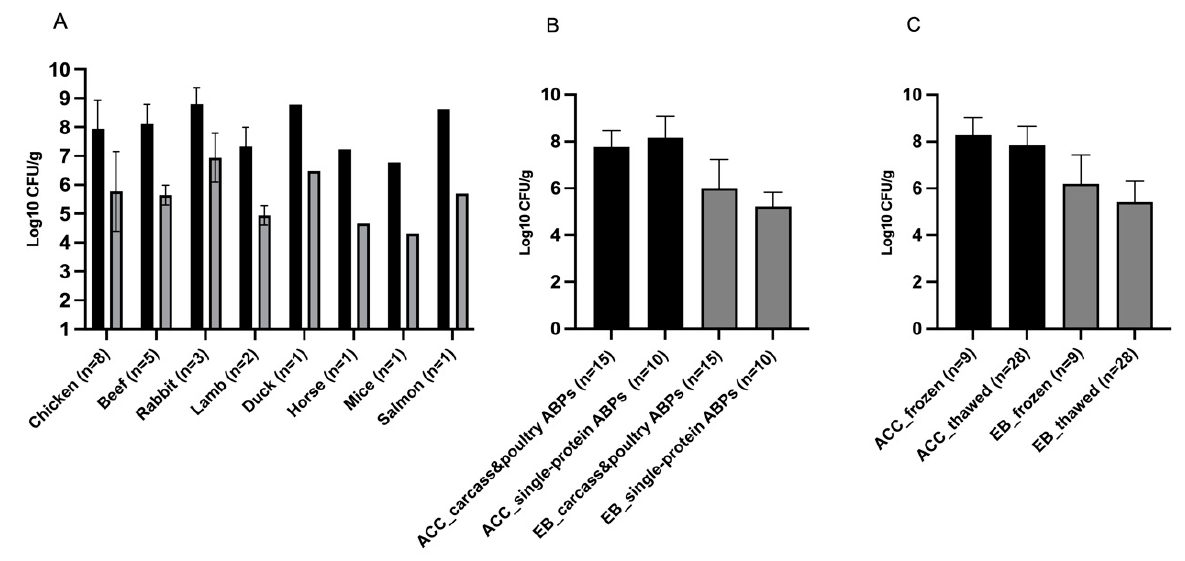
Figure 4. Microbial load (total ACC and Enterobacteriaceae Log 10 CFU/g) of RMBDs grouped according to protein source ( A ), composition ( B ), and storage condition at arrival (frozen or partially thawed) ( C ). Black bars indicate aerobic colony count, grey bars indicate Enterobacteriaceae load. ABPs, animal by-products; ACC, aerobic colony count; EB, Enterobacteriaceae ; CFU, colony-forming units. Error bar is SD. Table 5. Effects of the storage condition at arrival and specific animal source of RMBDs on aerobic colony and Enterobacteriaceae counts.